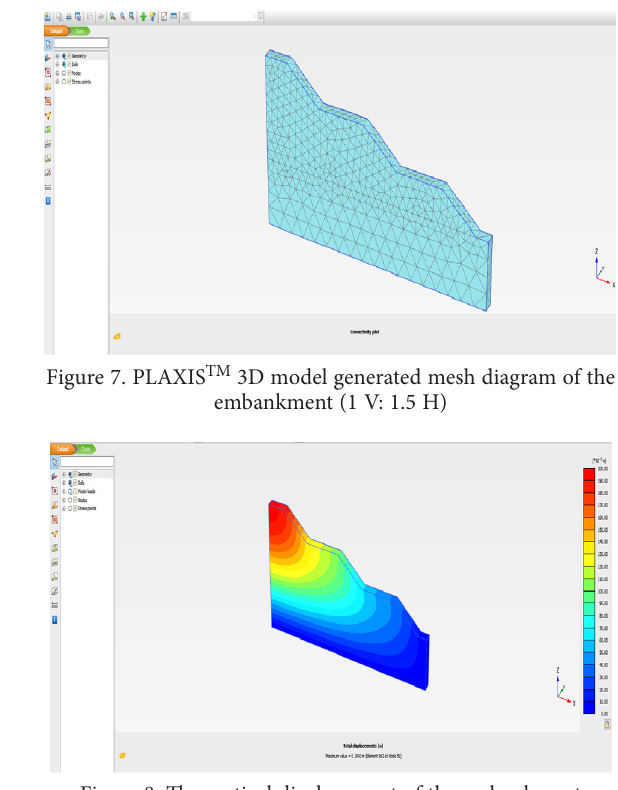
Figure 6. Comparison of soaked CBR values of contaminated